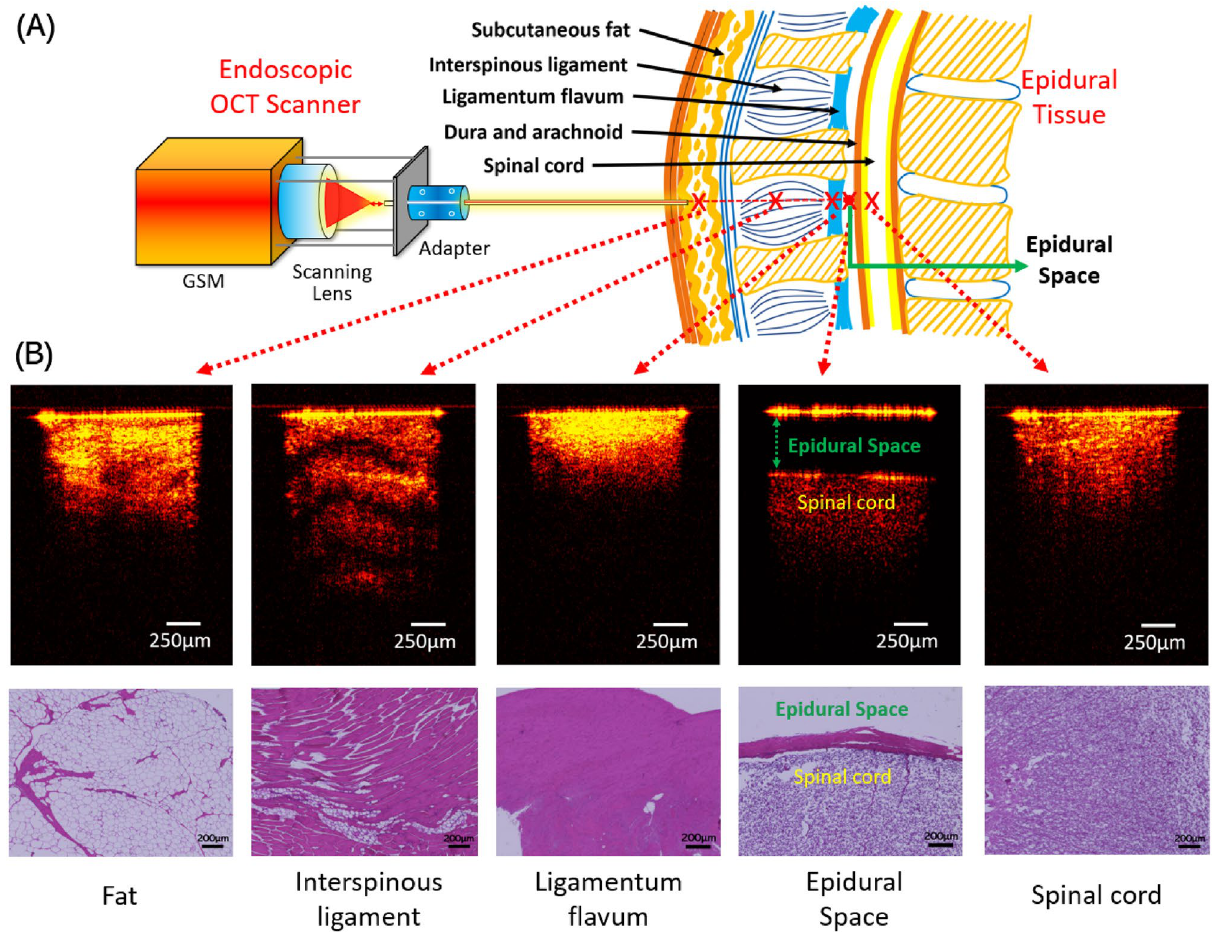
Figure 1. ( A ) Endoscopic OCT scanner setup and the representative OCT images of five epidural tissue layer categories. ( B ) Histology results of different tissue